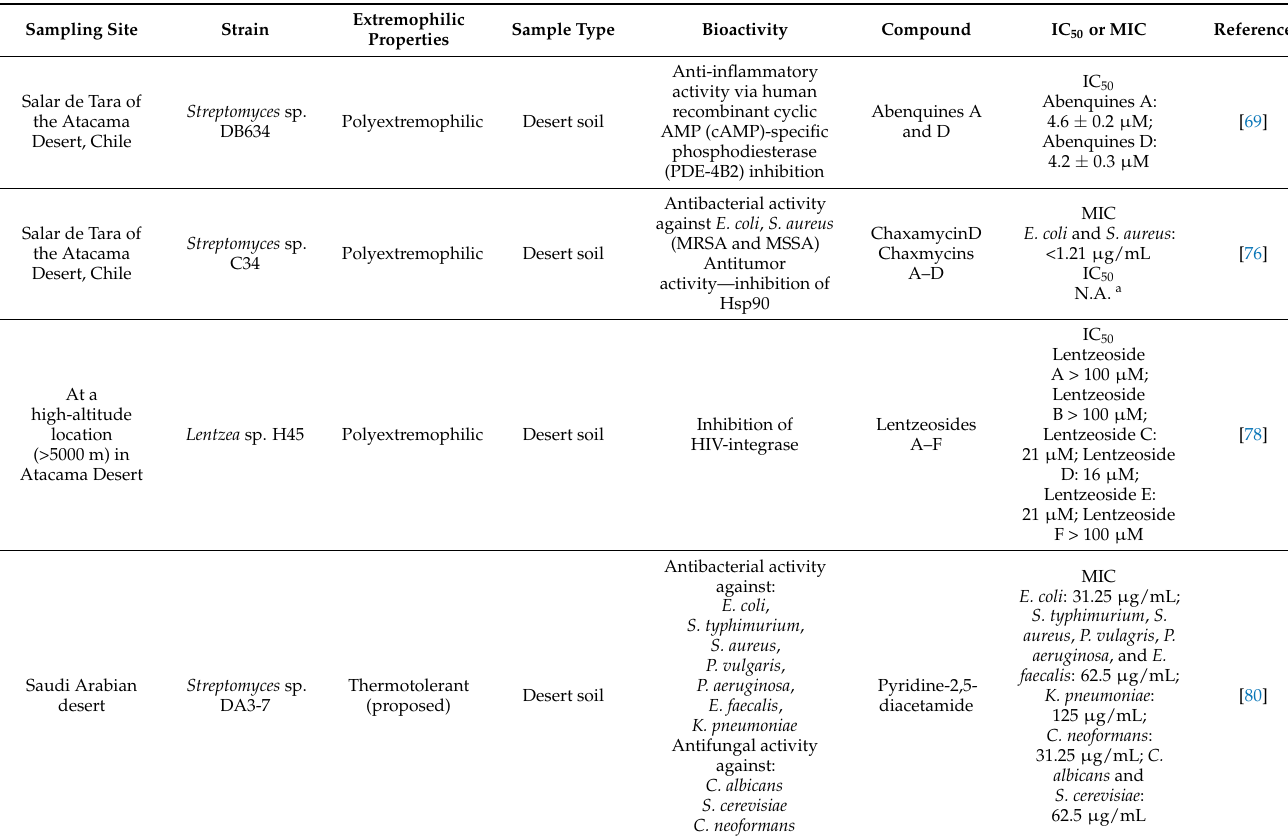
Table 1. Summary of bioactivity of actinobacterial strains isolated from the Atacama Desert. Sampling